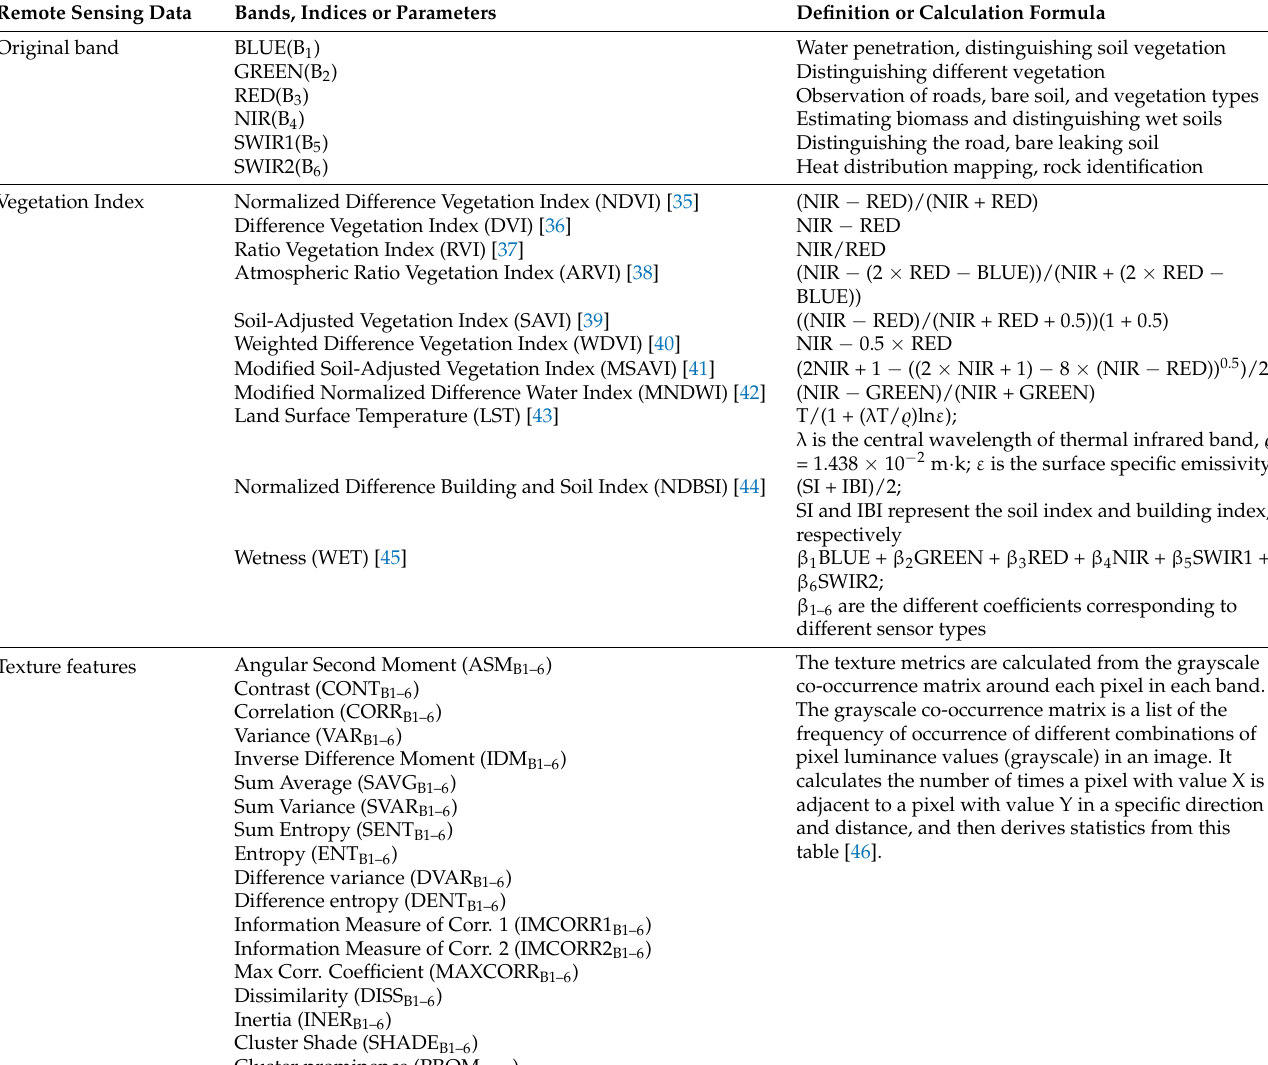
Table 2. Original bands, vegetation indices and texture features included in the analysis performed through the GEE platform. The corresponding calculation formula is provided for remote sensing factors when